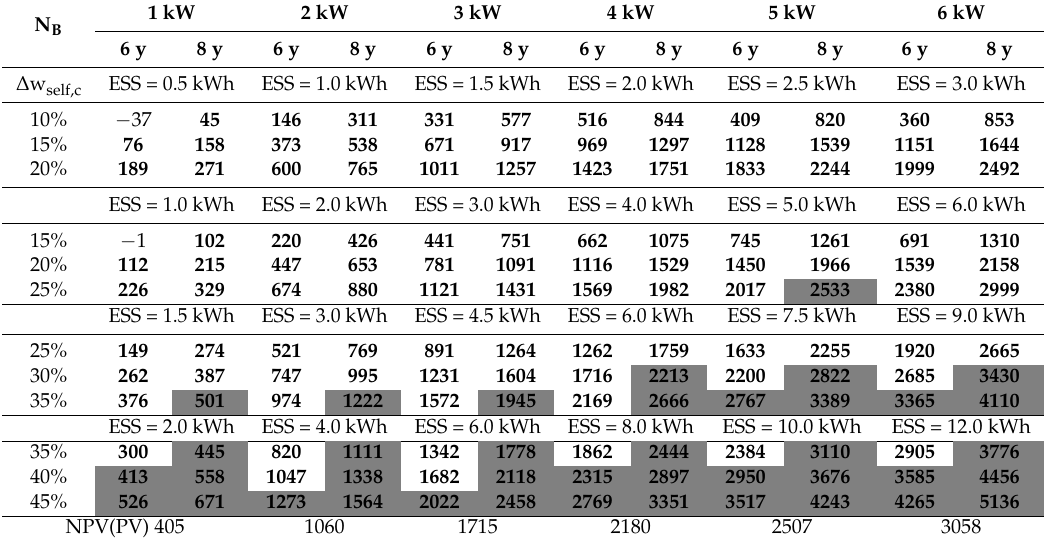
Table 9. Net Present Value ( € ) of integrated PV-battery systems with both redefined regional subsidies and a new policy of fiscal